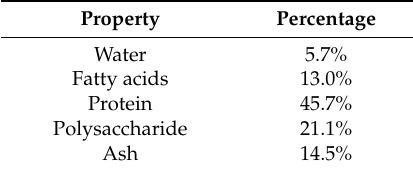
Table 5. Properties of the algal communities at the Minamisoma pilot plant.